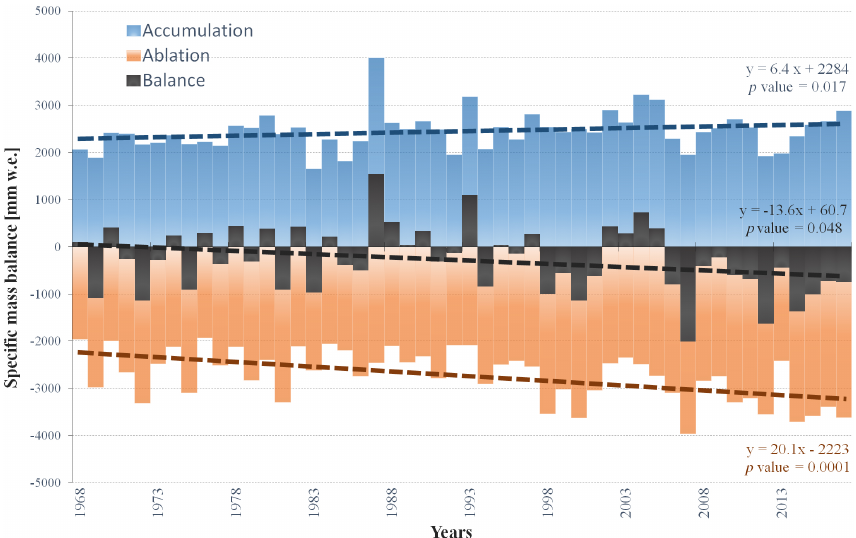
Figure 9. Fluctuations of the Djankuat glacier mass balance components in millimeters of water equivalent (mmw.e.) since the beginning of the observations in 1968 (https://wgms.ch/, last access: 13 September